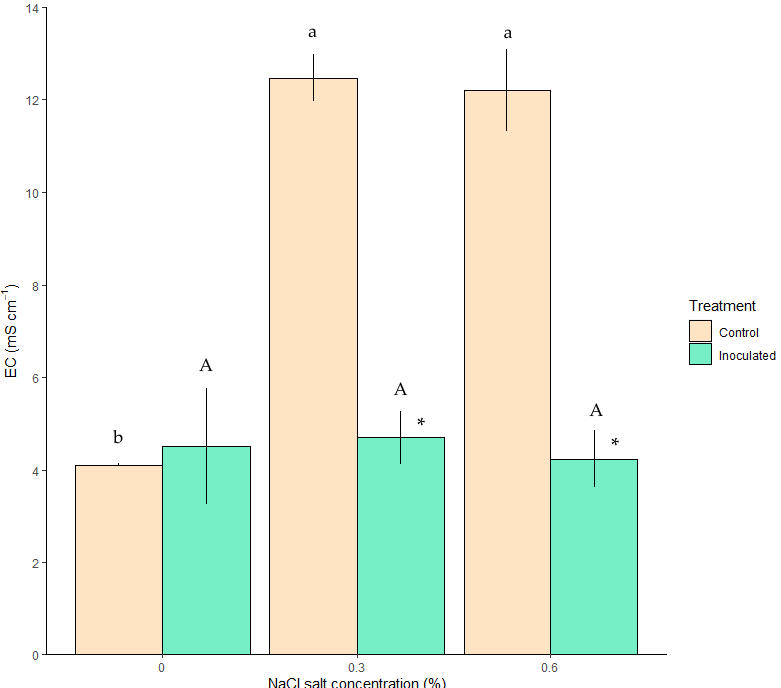
Figure 7. Electric conductivity, EC, (mS cm −1 ) measured three months after the beginning of the experiment in the lixiviate of the soil spiked with NaCl salt at two different concentrations. Lower- case and capital letters indicate significant differences among control and inoculated trea tments, respectively, at each NaCl soil concentration. * indicates statistically significant differences between the control and the inoculated treatment for each NaCl concentration.